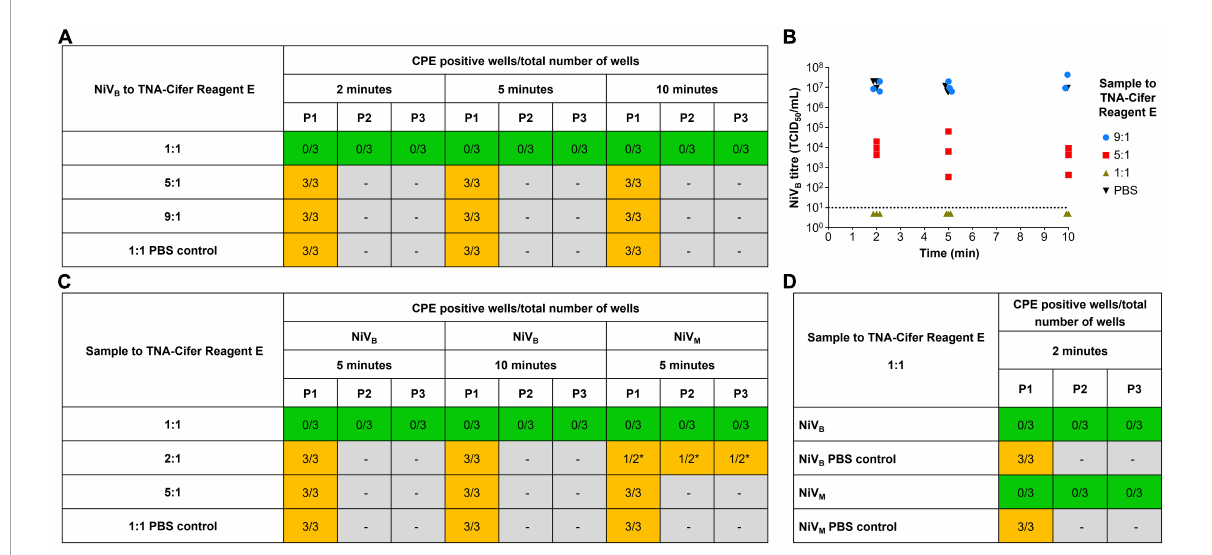
FIGURE3 Rapid sample processing inactivates Nipah virus. (A) NiV B recovery from samples (5.54 × 10 7 TCID 50 /mL) incubated with and without TNA-Cifer Reagent E at a 1:1, 5:1 and 9:1 ratio, for 2, 5 or 10 min at room temperature. (B) NiV B was incubated with TNA-Cifer Reagent E at 1:1, 5:1 and 9:1 ratio or PBS at 9:1 for the indicated times at room temperature and the virus titer determined by TCID 50 assays using Vero E6 cells. The dotted line indicates limit of detection of assays based on a starting 1/10 dilution of samples. This experiment was performed one time, with three samples taken per time point. (C) NiV recovery from samples (NiV B 5.54 × 10 7 TCID 50 /mL; NiV M 1.89 × 10 7 TCID 50 /mL) incubated with and without TNA-Cifer Reagent E at a 1:1, 2:1 and 5:1 ratio for 5 and/or 10 min at room temperature. (D) NiV recovery from samples (NiV B 5.54 × 10